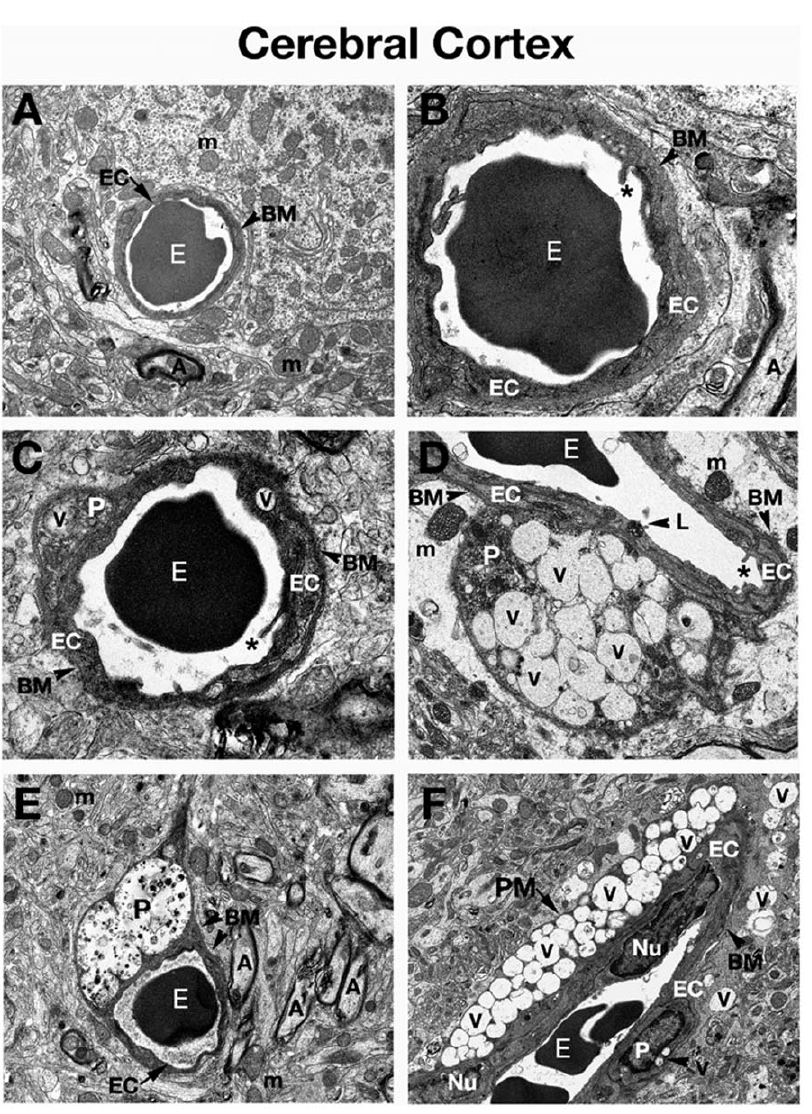
Figure 1. Electron microscope examination of the cerebral cortex of Naglu mutant mice. ( A ) Representative area of C57 BL/6J control mouse cerebral cortex characterized by normal ultrastructural appearance of neurons, myelinated axons, and capillaries. ( B ) Capillary at high magnification from the cerebral cortex of control mouse consists of a single layer of endothelial cells surrounded by a layer of basement membrane, forming an intact BBB. Erythrocytes can be observed in the lumen of the capillary. Organelles in all cells were well preserved. ( C ) In the cortex of Naglu mutant mouse at 3 months of age (early symptomatic), endothelial cells and pericyte show formation of numerous large vacuoles in their cytoplasm. Microvilli and their fragments can be observed floating free in the capillary lumen. ( D ) Highly vacuolated pericyte was found in contact with microvessel basement membrane in 3 months old mutant mice. Edematous space is observed around vessels. ( E ) In late symptomatic (6 months of age) mutant mouse, large vacuoles containing light and dark material cause swelling of a pericyte, displacing organelles. ( F ) Longitudinal section of capillary showing large perivascular macrophage with numerous vacuoles in its cytoplasm near the blood vessel in the cortex of a 6 month old Naglu mouse. Numerous vacuoles were found in cells surrounding the capillary. EC - endothelial cell, BM - basement membrane, E – erythrocyte, m – mitochondrion, A – axon, P – pericyte, PM – perivascular macrophage, Nu – nucleus, V – vacuole, L – lysosome, asterisks - microvilli. Magnifications: ( A ), ( D ), ( F ): 7,100x; ( B ), ( C ): 14,000x; ( E ): 4,400x.